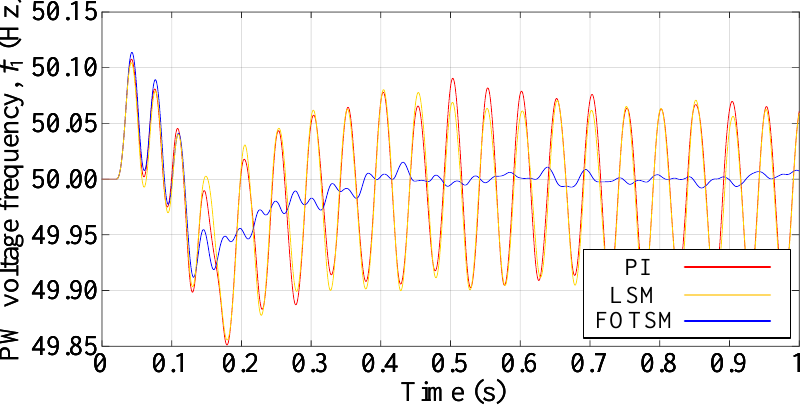
Figure 6. The PW voltage frequency responses under PI, LSM, and FOTSM during the start-up